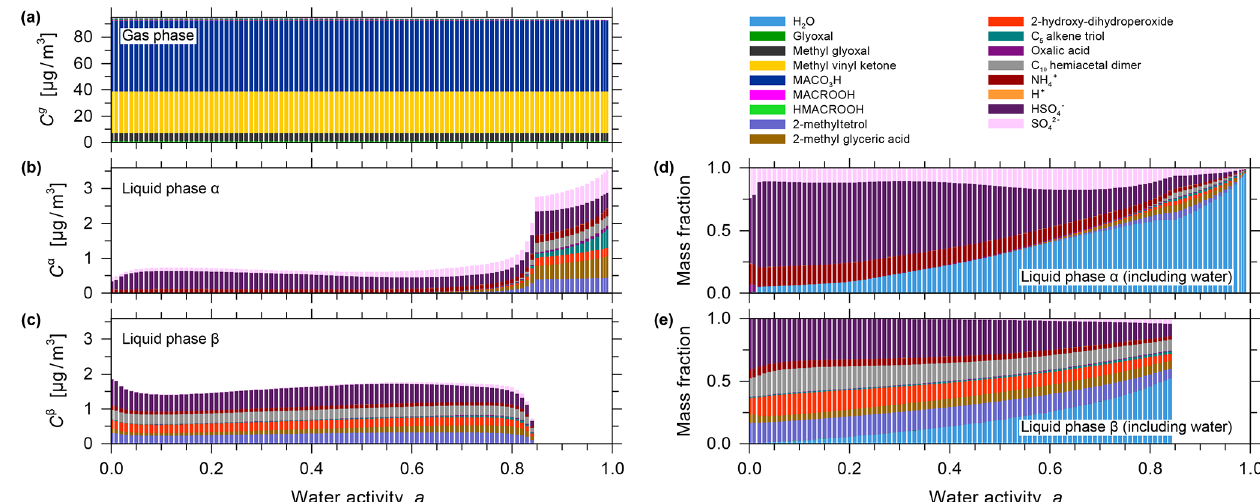
Figure 7. Compositions of (a) the gas phase and (b, c) the liquid aerosol phases (exclusive of the present water content) predicted by the bulk equilibrium gas–particle partitioning model. The calculations were carried out for 10 ◦ C, variable water activity (0% to 99%), a reacted isoprene concentration of 130µgm − 3 , and 1.3µgm − 3 ammonium bisulfate. The model predicts LLPS to occur between 0% and 84% RH. (d, e) Mass fractions of all species (including water) in the liquid phases.